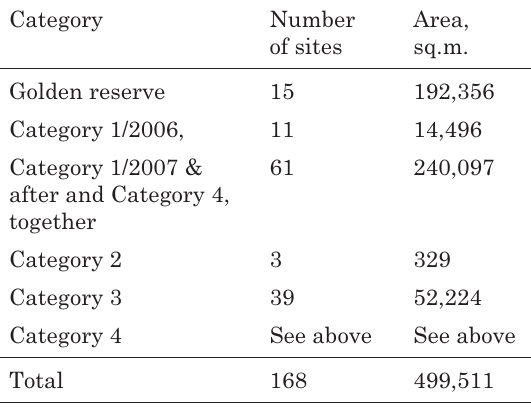
Table 1. Initial classifi cation of vacant